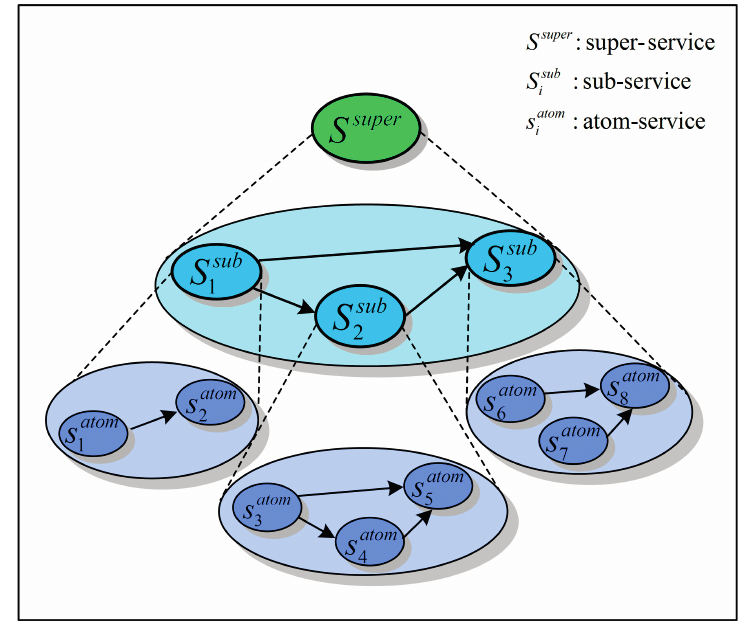
Figure 2. Mapping procedure from a service request to a SCA in WSNs by the